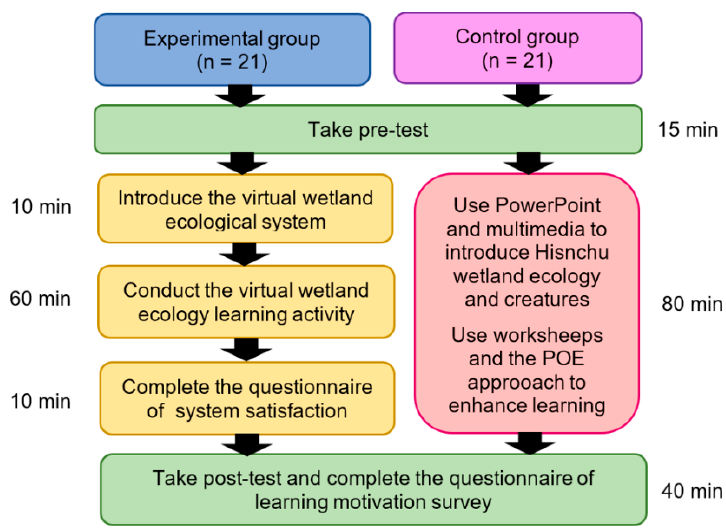
Figure 11. Flowchart of the teaching experiment by two groups. According to the POE strategy, the learning process was divided into three stages.